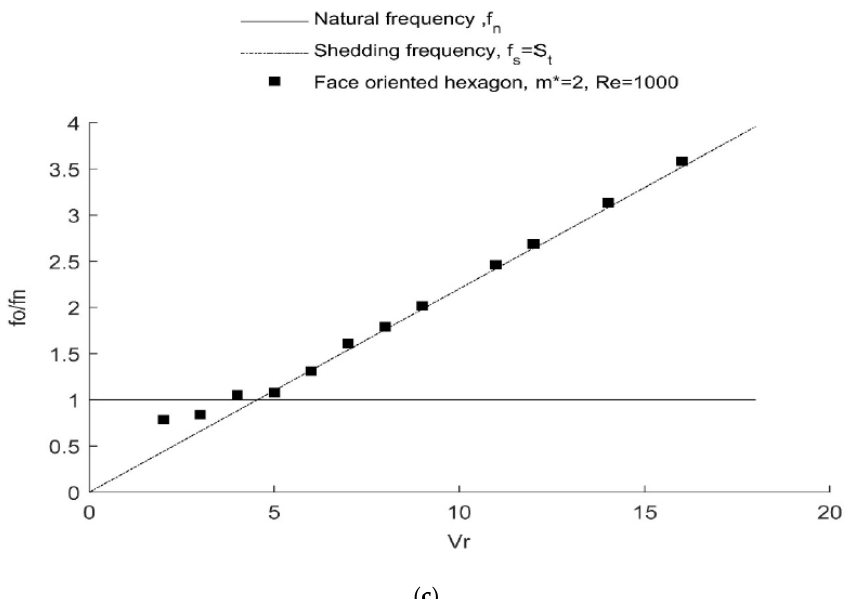
Figure 3. The VIV response of a circular and hexagonal cylinder at different reduced velocities, ( a ) normalized amplitudes, ( b ) normalized frequency for corner-oriented hexagon, and ( c ) normalized frequency for face-oriented hexagon.